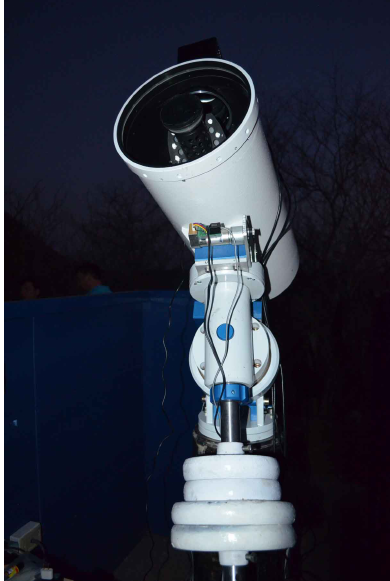
Figure 1. ORI-25 at the Cosala site in early 2012.